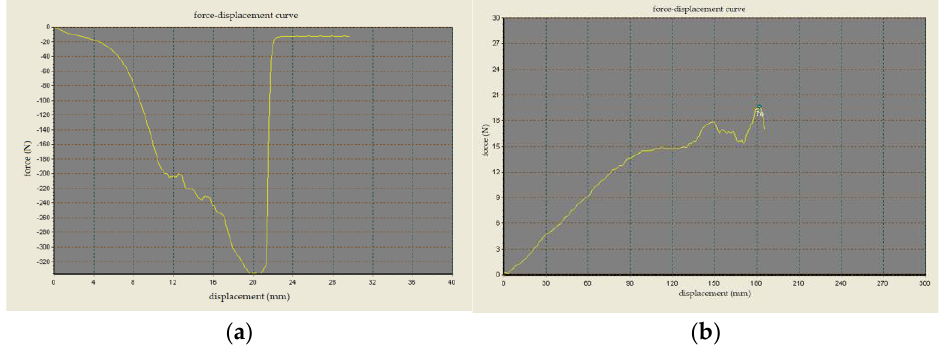
Figure 4. The results of mechanical testing. ( a ) Tensile breaking test of corn ear. ( b ) Bending fracture test of corn ear.